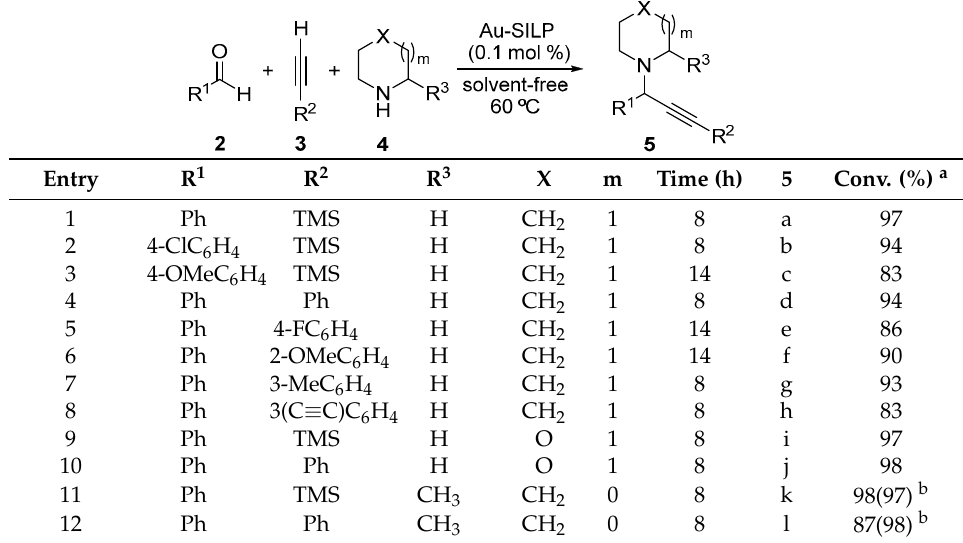
Table 2. A 3 coupling reaction catalyzed by Au–SILP.